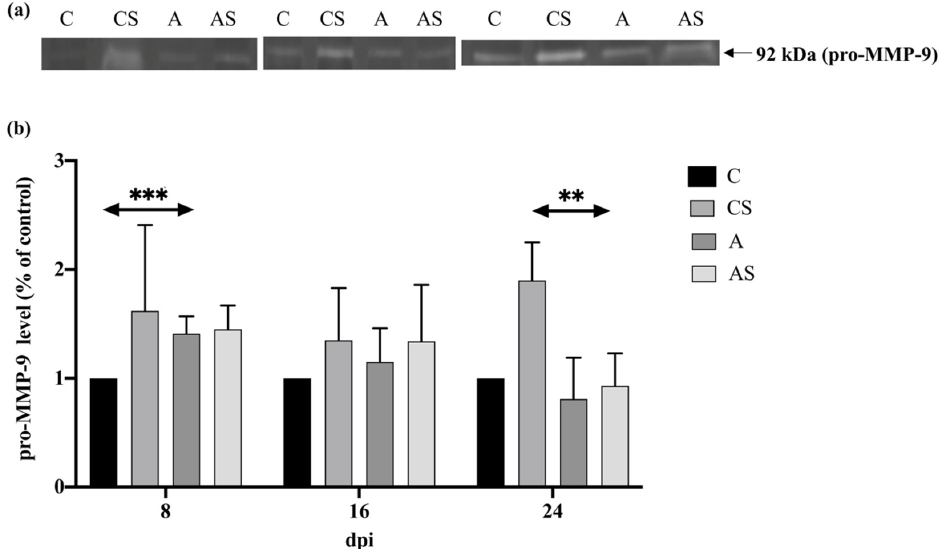
Figure 5. Pro-metalloproteinases-9 (pro-MMP-9) levels in the kidneys of mice infected with Acanthamoeba spp. pro-MMP-9 was determined using zymography. Representative zymography ( a ) and densitometric analysis of pro-MMP-9 protein ( b ) in mouse kidneys were shown. Data represent the means ± standard deviation for six independent experiments. (A: Immunocompetent mice infected with Acanthamoeba spp.; AS: Immunosuppressed mice infected with Acanthamoeba spp.; dpi: Days post Acanthamoeba spp. infection; C: Immunocompetent mice uninfected with Acanthamoeba spp.; CS: Immunosuppressed mice uninfected with Acanthamoeba spp.; statistically significant differences * p < 0.05; ** p < 0.01; *** p < 0.001).